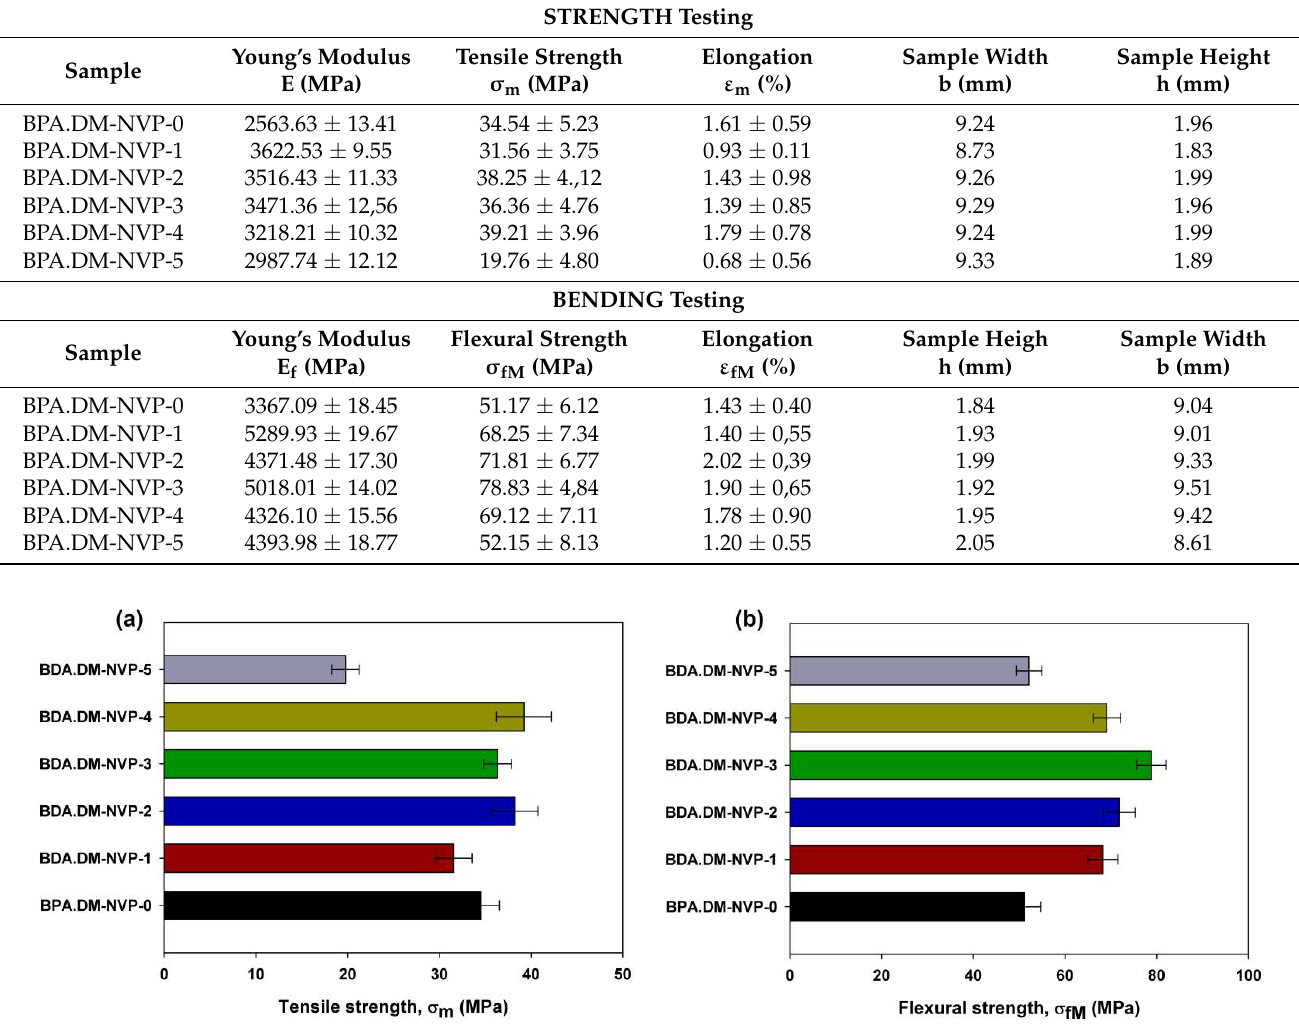
Figure 9. Stress diagram for various test specimens obtained during the uniaxial tension ( a ) and the bending test ( b ).